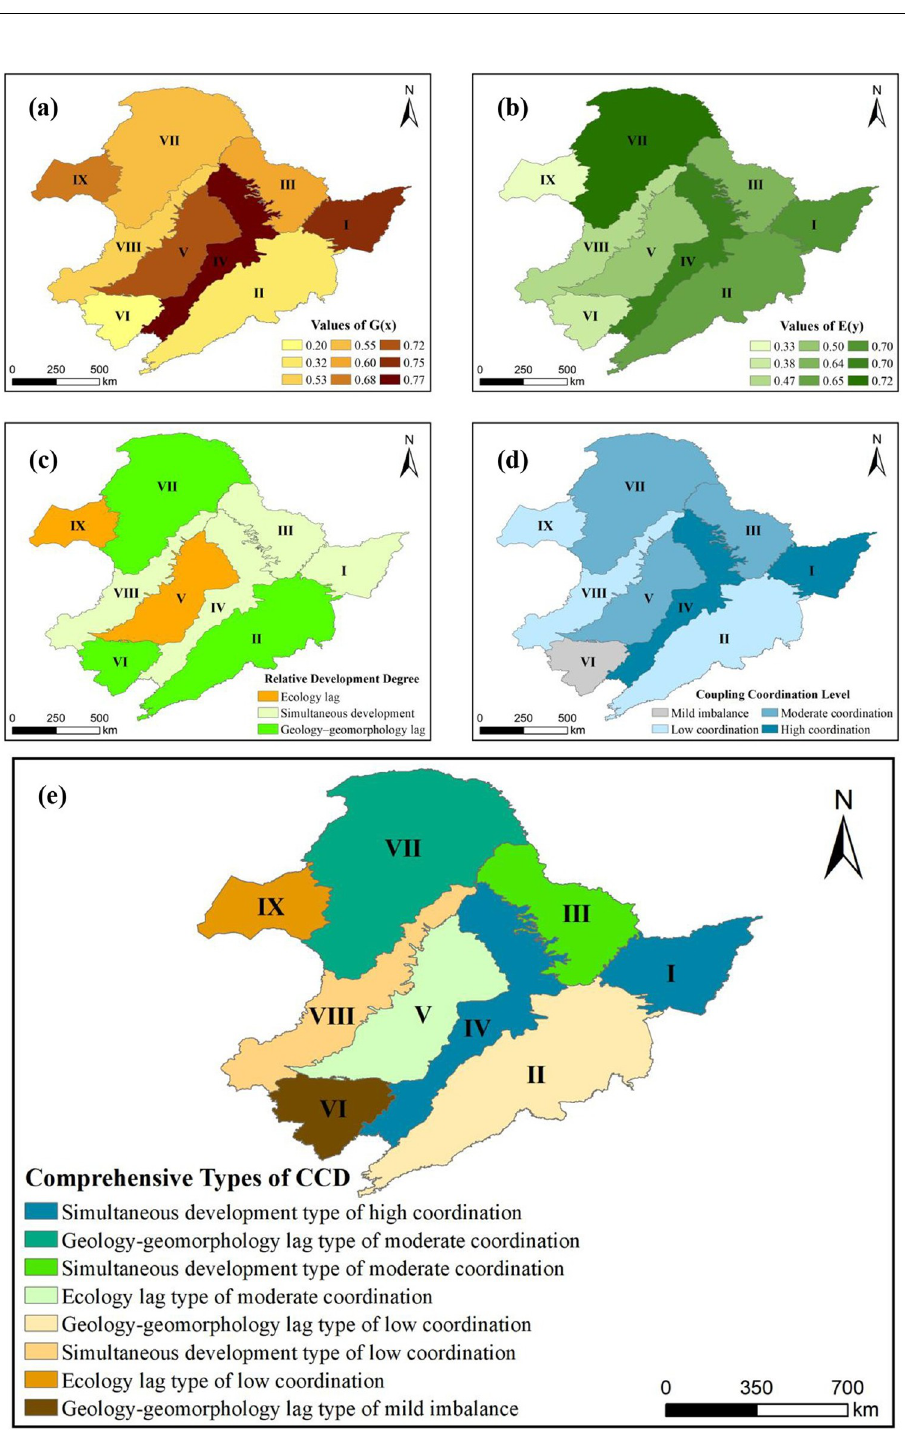
Fig 4. Spatial differentiation of coupling coordination between geology–geomorphology and ecology in Northeast China. (a) Comprehensive evaluation results of geology–geomorphology; (b) Comprehensive evaluation results of ecology; (c) Relative development degree between geology–geomorphology and ecology; (d) Coupling coordination degree between geology–geomorphology and ecology; (e) Comprehensive evaluation of development level and coupling coordination type. All maps were processed using software ArcGIS 10.4